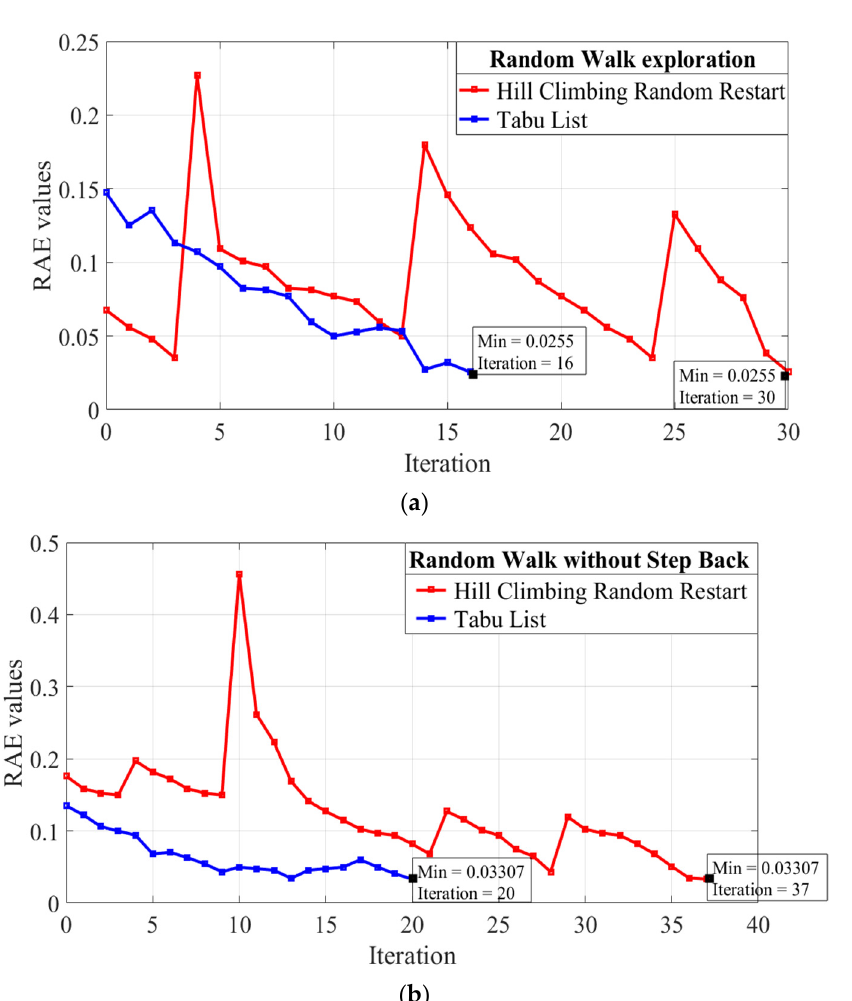
Table 2. Results for prediction of the RW and RW_WSB performance.